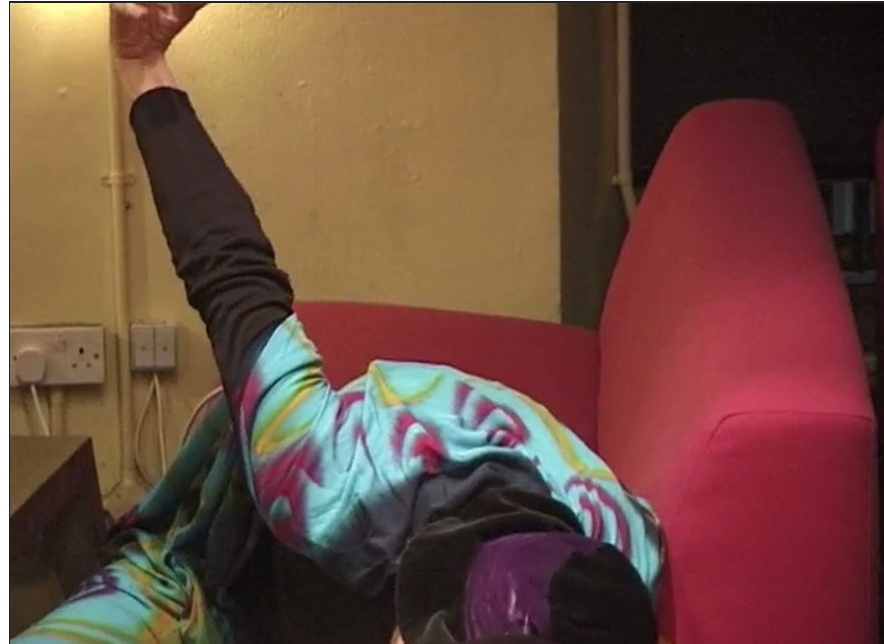
Figure 2.4: (49.45) Jennifer Pike with Birdyak at the RCA, London 2002. Courtesy of William Cobbing.